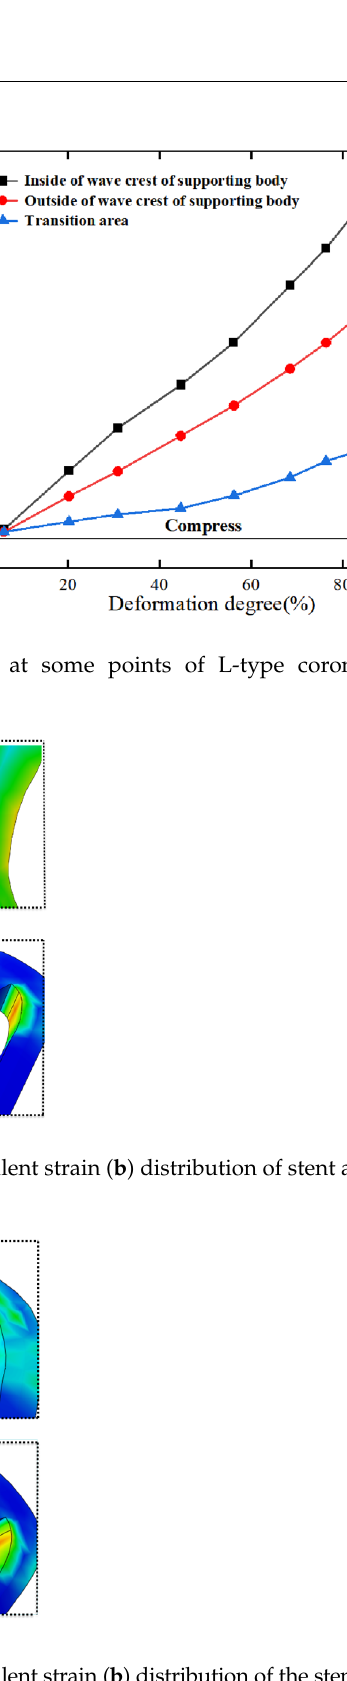
Figure 10. The equivalent stress ( a ) and equivalent strain ( b ) distribution of the stent after spring-back.